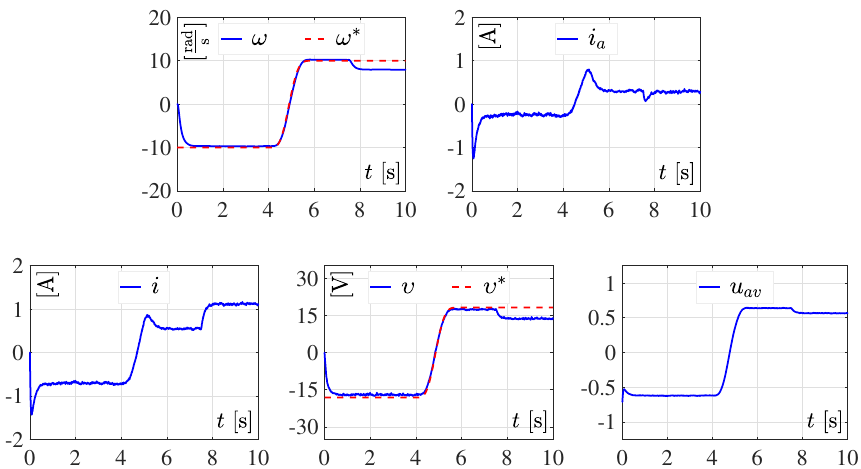
Figure 1. Experimental results of the passivity-based control reported in [41], when ω ∗ is of the Bézier type (22), and the abrupt variations in load R , declared in (26), are carried out in the system.